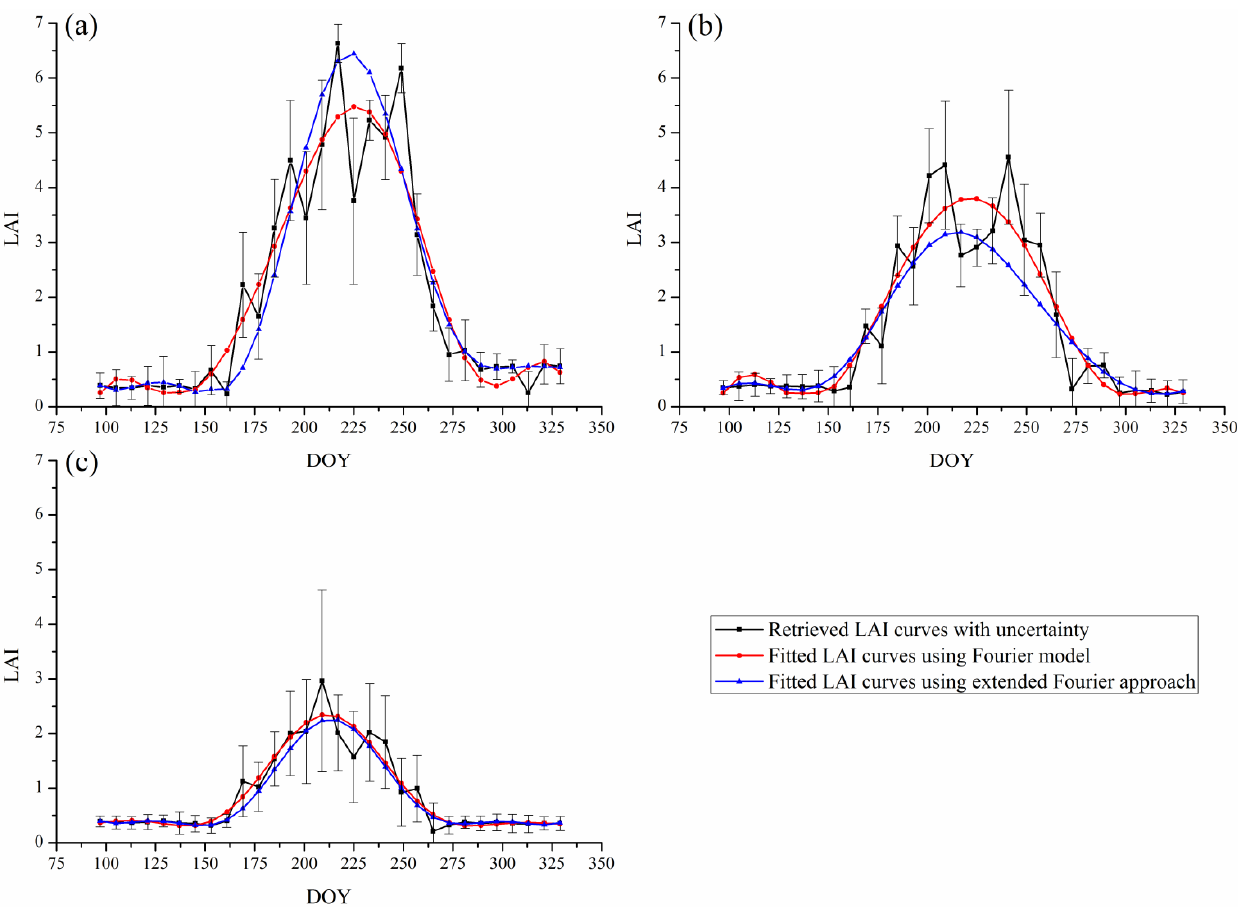
Figure 9. Comparison between the LAI r , LAI F , and LAI eF values of three pixels from dense vegetation to sparse vegetation in the time series. ( a ) and ( b ) are the LAI r of vegetation near Wutumeiren river; ( c ) is the LAI r of vegetation in drought area.